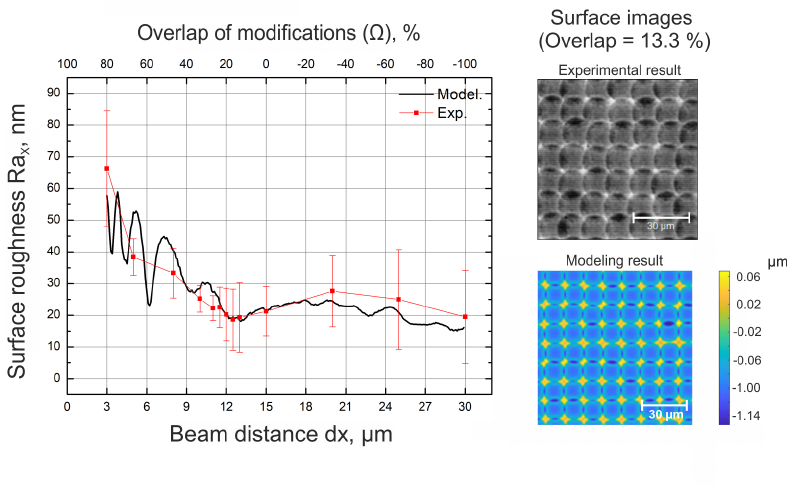
Figure 6. Surface roughness (in the scanning direction) dependence on the overlap of modifications (on the left ). Surface images after single-pass machining acquired experimentally and via numerical calculations when the overlap of modifications is 13.3 % (on the right ). The laser source used was laser source number 3